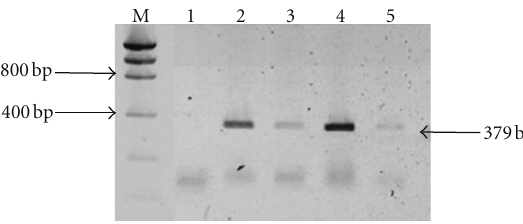
Figure 1: Agarose gel electrophoresis analysis of PCR amplification of extracted DNA from lobster feces. PCR was performed using Primers NHP/F2 and NHP/R2 [9]. Lane M indicates low-mass DNA marker, Lane 1 feces from control lobster, Lanes 2, 3, and 5 feces from treatment lobster, Lane 4 positive control NHPB of shrimp